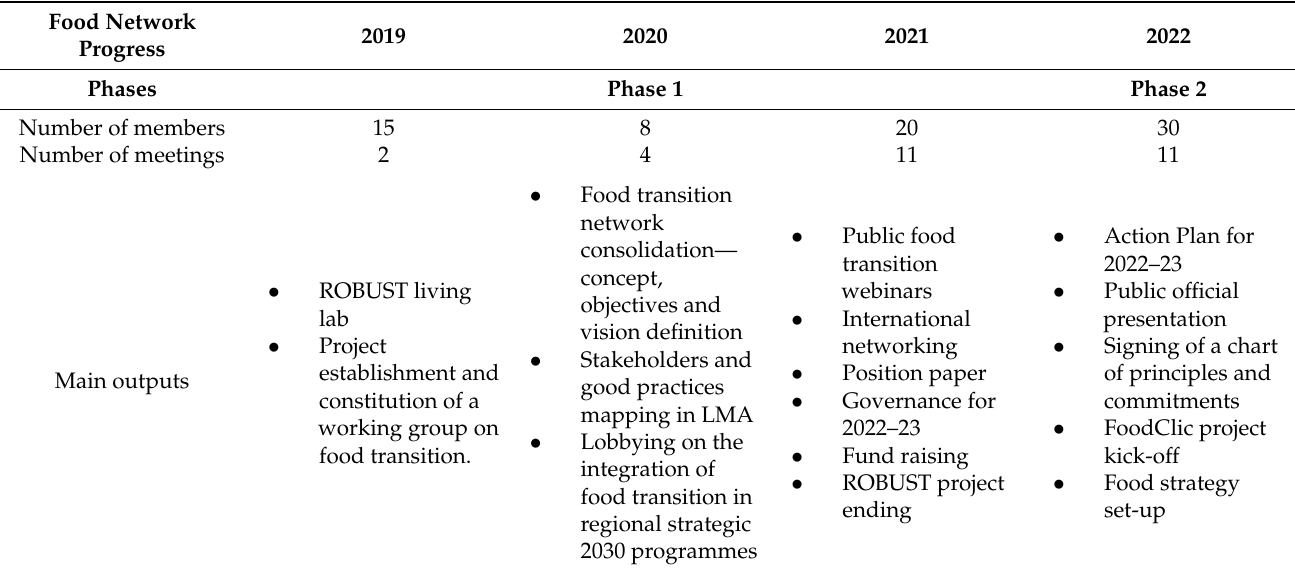
Table 1. Timeline of the main steps towards the creation and consolidation of the food network for the food transition in the LMA by the ROBUST project in 2019 until the FoodClic project launched in